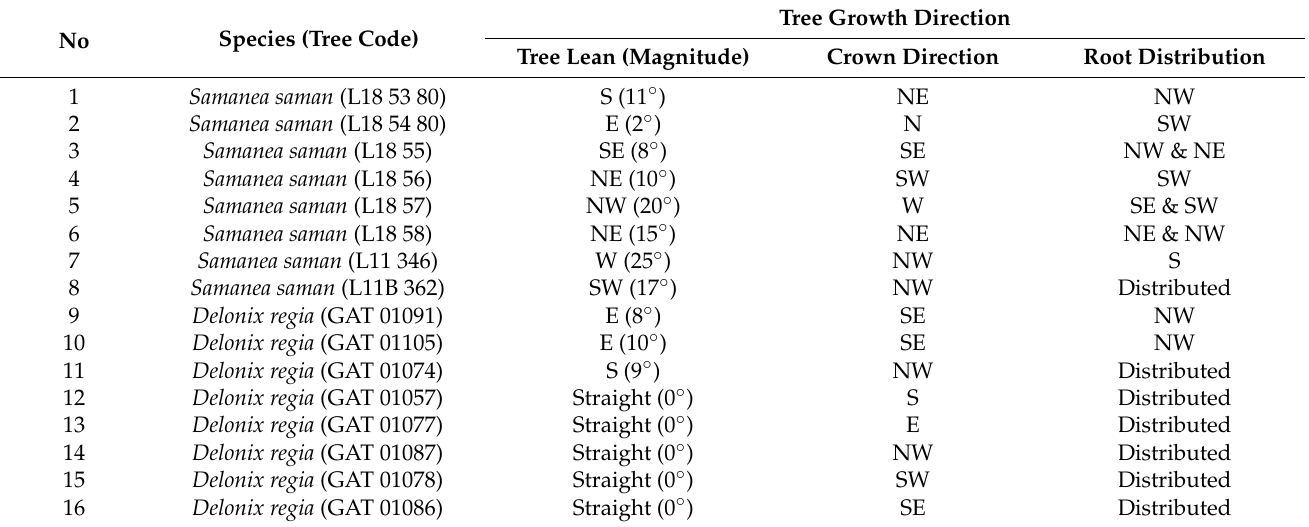
Table 2. The direction of tree lean and crown development related to root lateral distribution.